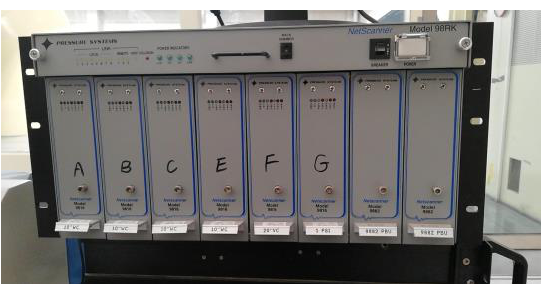
Figure 4. Pressure-scanning instrument.